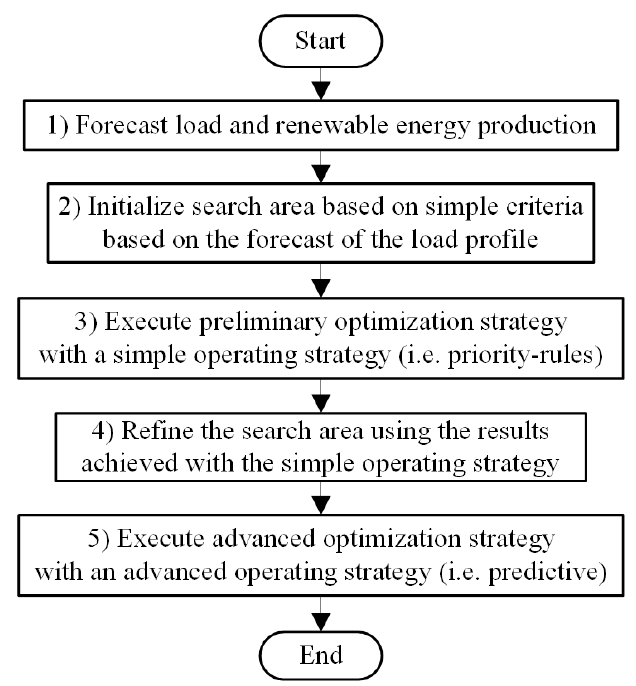
Figure 2. Workflow for the definition of simplified advanced